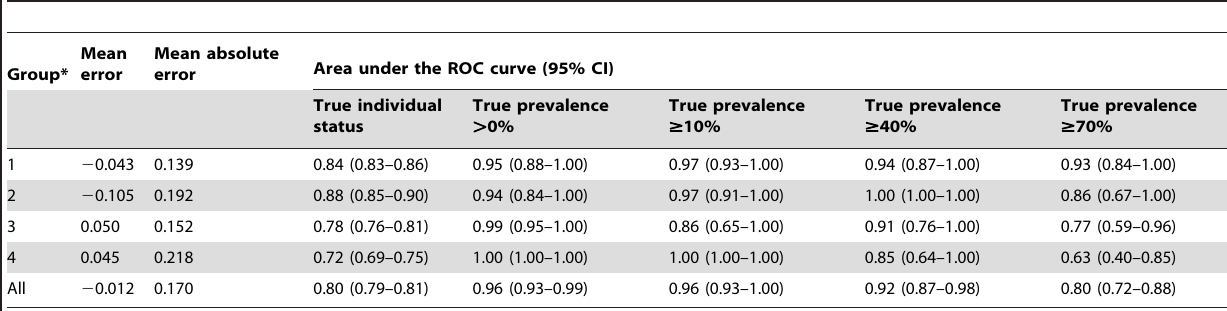
Table 3. Validation analysis of spatial predictions from a Bayesian mixed-effects spatial logistic regression model for trachoma (follicular, TF, or inflammation, TI) in children aged 1–9 years, Southern Sudan.